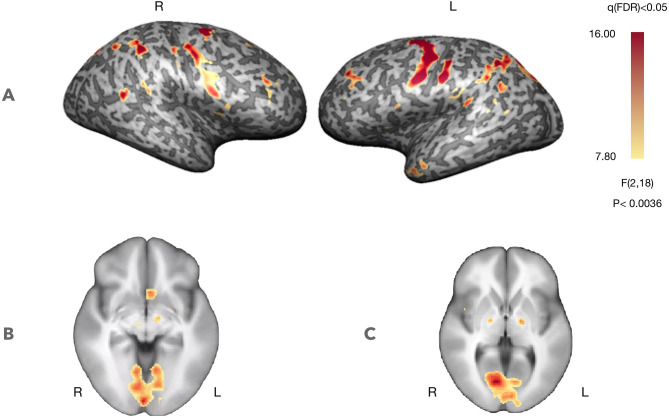
Self-regulation with neurofeedback (N = 10, considering both NF runs). Statistical maps for the ANOVA, 3-level within-subject analysis (FDR corrected q < 0.05) increased activation in prefrontal control regions and regions involved in feedback processing. (A) Statistical map projected on a participant's inflated cortex. (B) Statistical map projected on an average of the individual anatomical data sets (radiological convention)—ventral striatum (Z = −5, Talairach coordinates). (C) Statistical map projected on an average of the individual anatomical data sets (radiological convention)—dorsal striatum (Z = 3, Talairach coordinates).